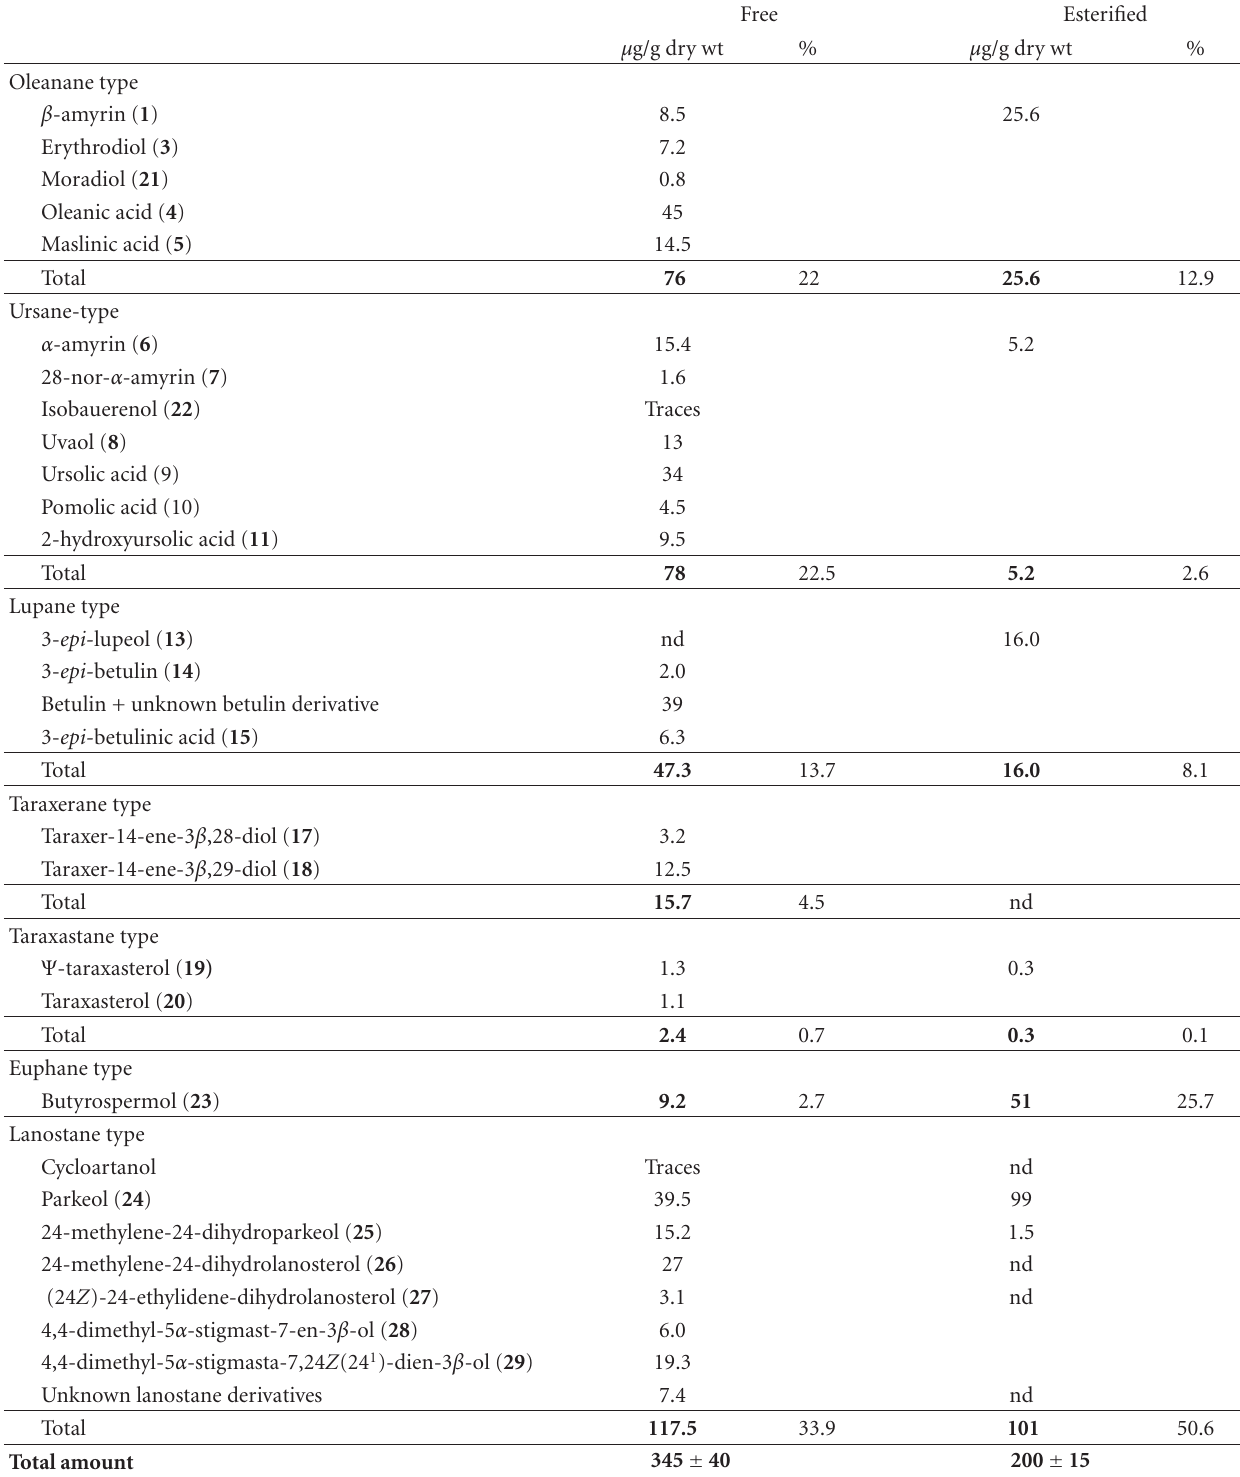
Table 5: Amounts of free and esterified nonsterol triterpenoids in Olea europaea callus cultures.